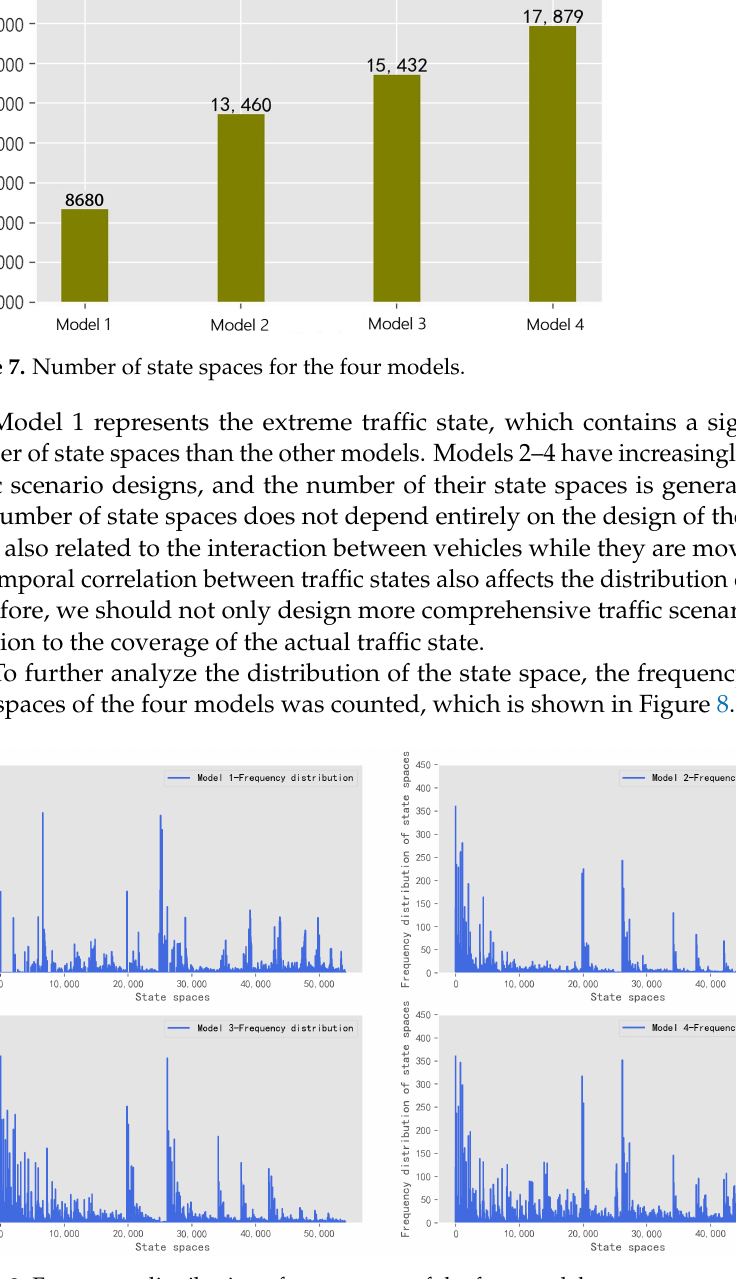
Figure 8. Frequency distribution of state spaces of the four